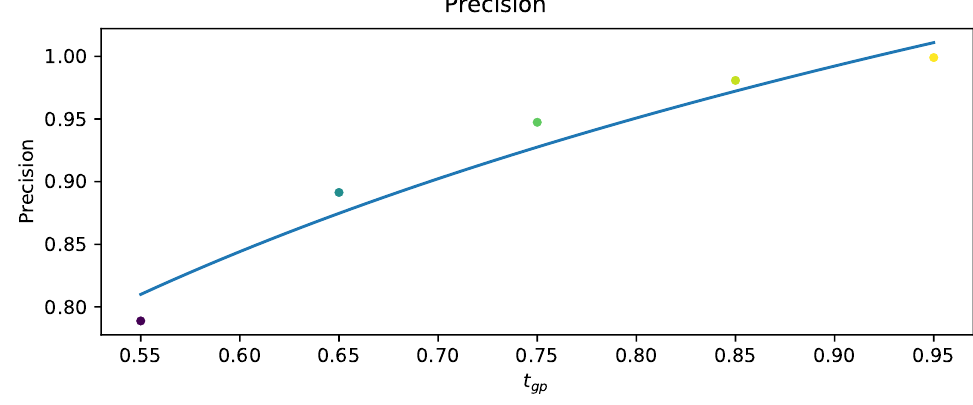
Figure A3. Dependence of annotation precision on t gp